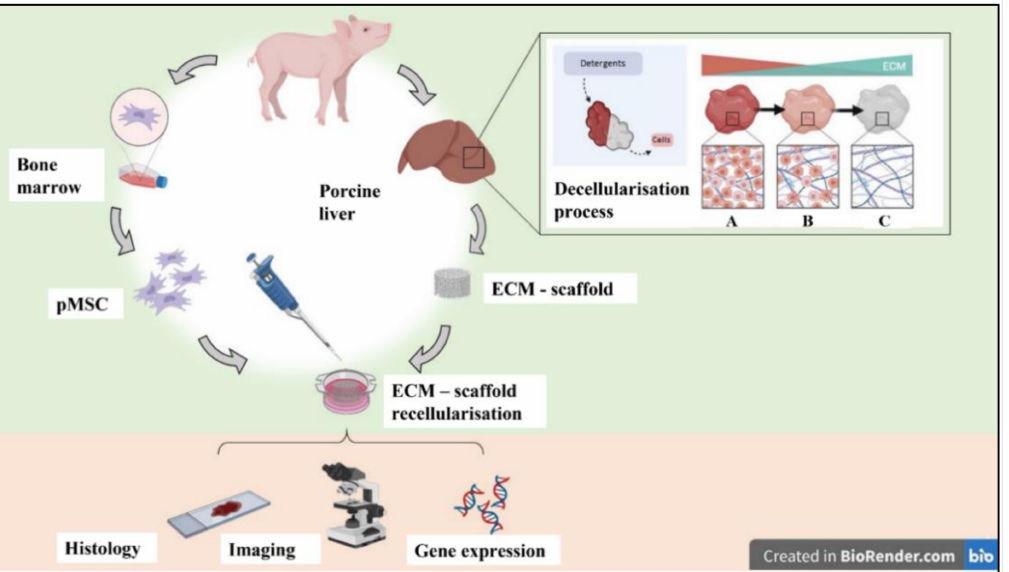
Figure 1. Schematic representation of the experimental design for